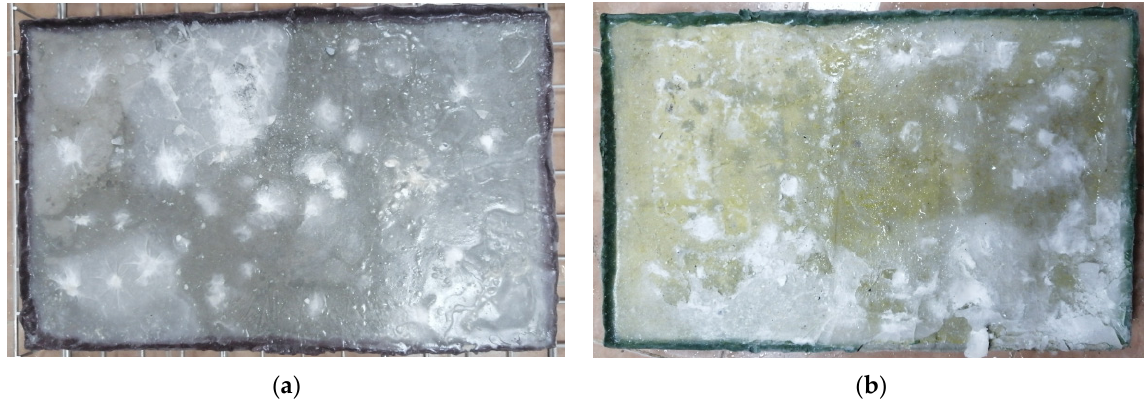
Figure 6. Specimens, after being subjected to impact loading. ( a ) Not coated, ( b ) Coated.